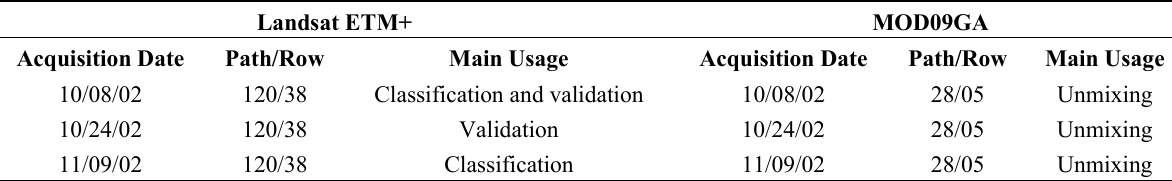
Table 1. Test data for comparing the original algorithm and the proposed algorithm ( i.e. , Spatial and Temporal Data Fusion Model (STDFM) and Enhanced Spatial and Temporal Data Fusion Model